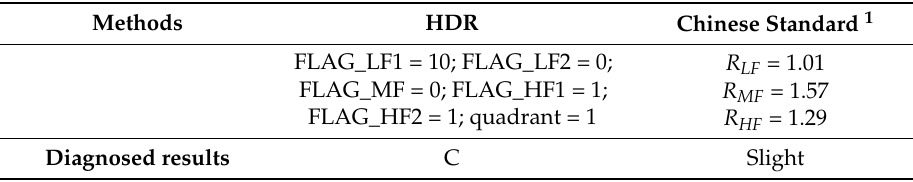
Figure 12. Results of Case 2 using the HDR classifier: ( a ) FR plot with boundaries of frequency sub-bands; ( b ) eroded binary image. Table 4. Diagnosis result of Case 2.